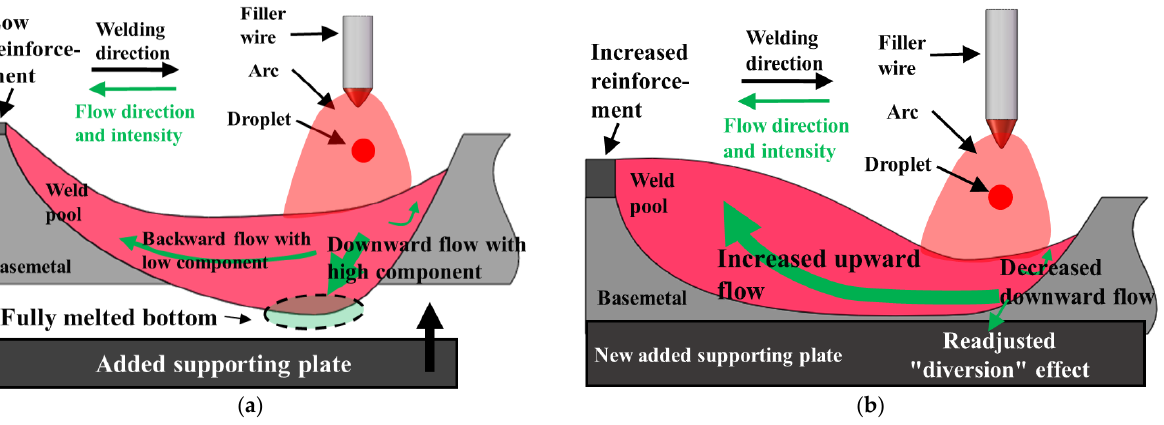
Figure 12. Comparison of flow pattern. ( a ) without supporting plate; ( b ) with supporting plate.